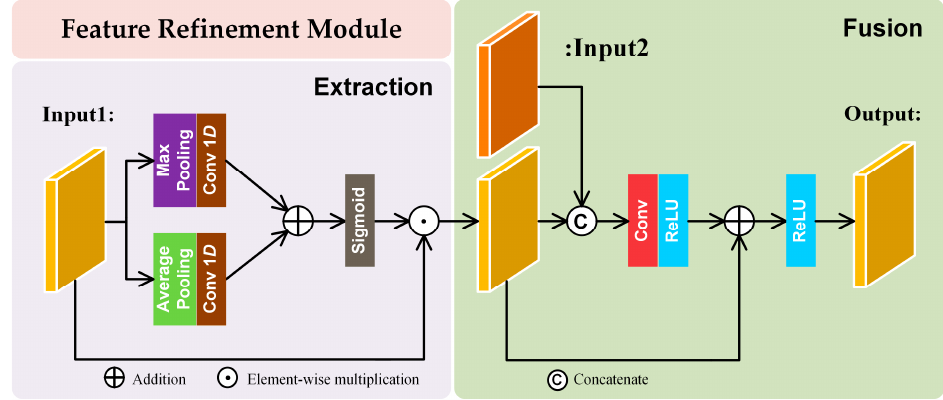
Figure 5. Architecture of the feature refinement